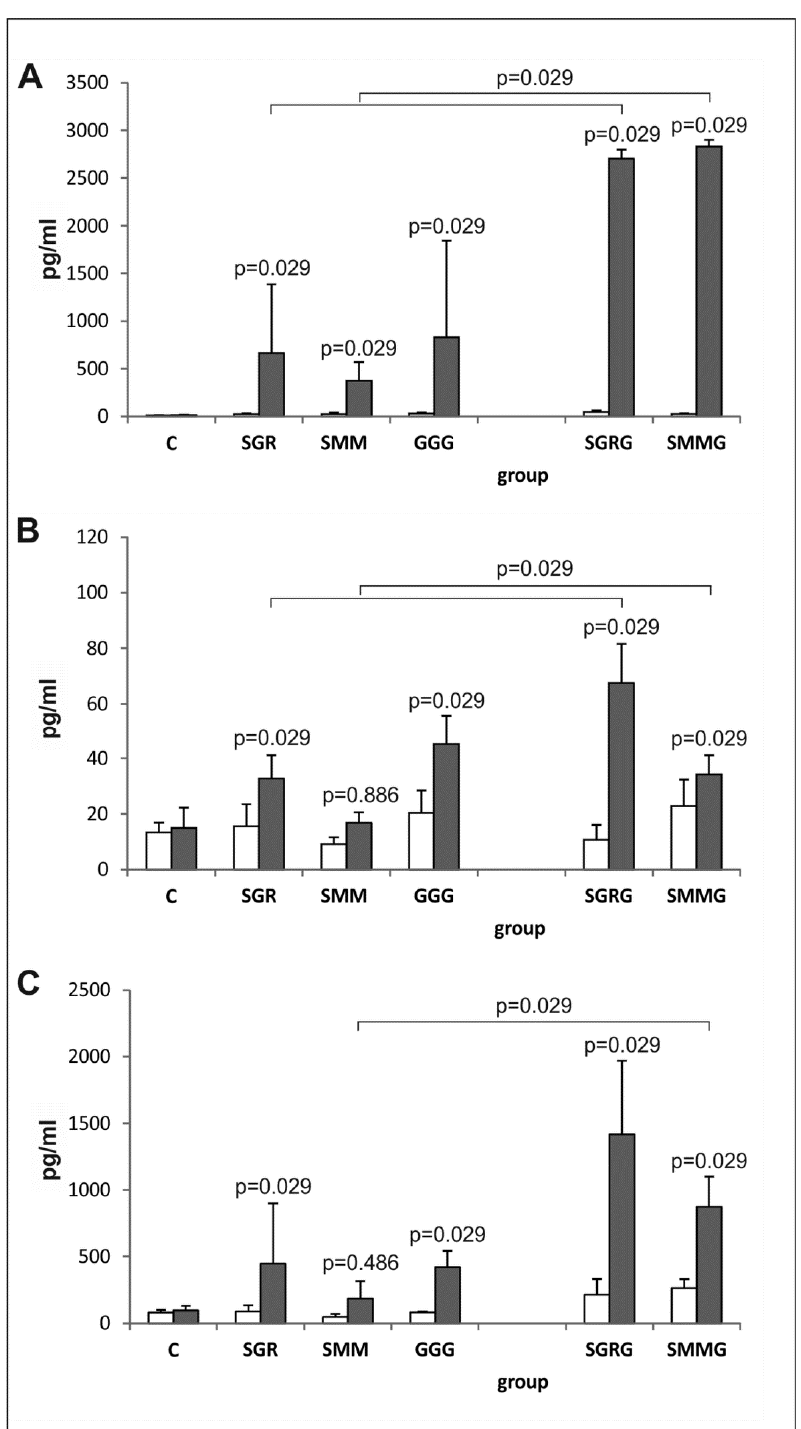
Figure 5. In vitro cytokine synthesis by splenocytes from immunized and control mice. ( A ) IFN- γ , ( B ) IL-2 and ( C ) IL-10 in vitro synthesis by splenocytes from mice immunized with chimeric T. gondii antigens and control mice in unstimulated ( □ ) and TLA-stimulated ( ■ ) cultures; p values for statistically significant differences in cytokine production after TLA stimulation compared to control splenocytes from non-immunized mice (C) are given above bars; statistically significant differences in cytokine levels between groups immunized with trivalent antigens and their tetravalent counterparts after TLA stimulation are marked with brackets.